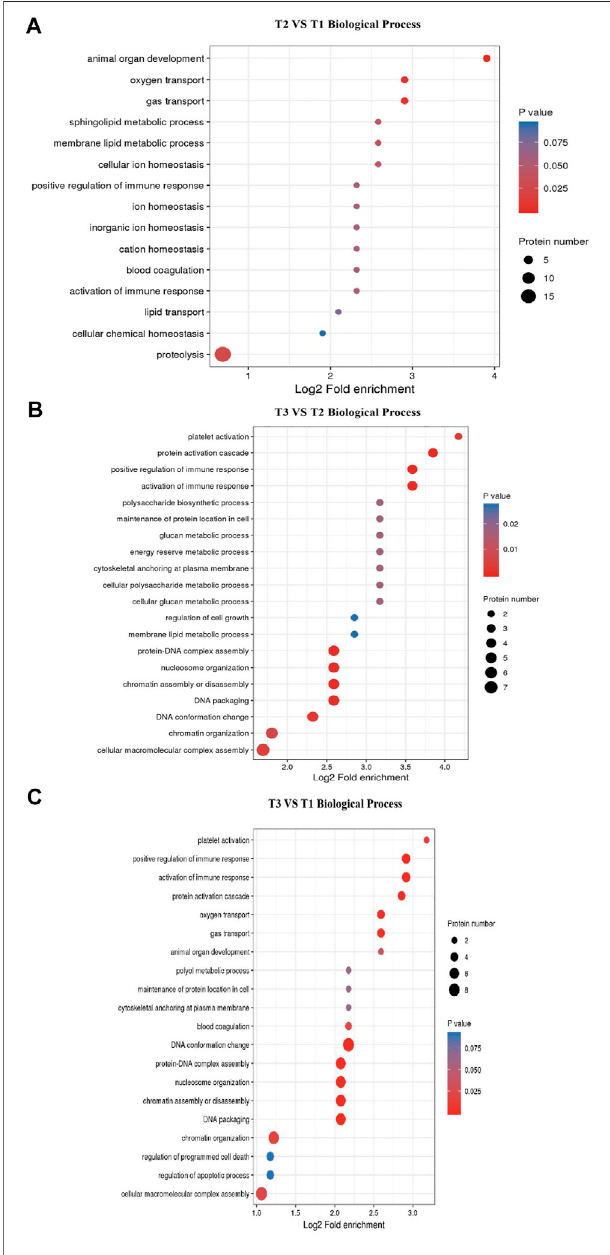
FIGURE 4 | GO terms enrichment for Biological Process. (A) T2 VS. T1 Biological Process items. (B) T3 VS. T2 Biological Process items. (C) T3 VS. T1 Biological Process